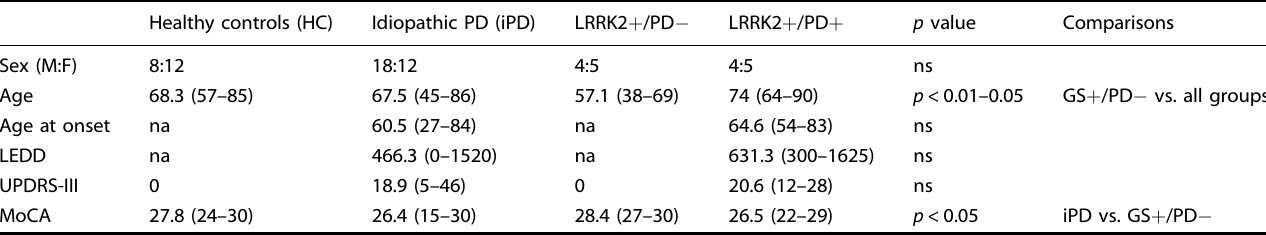
Table 2. Summary of demographics of study participants (CUMC cohort).